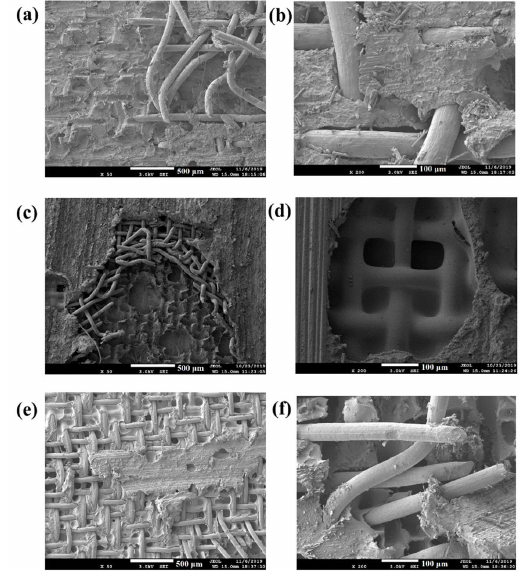
Figure 13. SEM of lap shear failure surfaces with similar LSS obtained with different types of heating elements: ( a ) type A heating element, LSS=37.3 MPa, × 50, ( b ) type A heating element, LSS=37.3 MPa, × 200, ( c ) type B heating element, LSS=35.6 MPa, × 50, ( d ) type B heating element, LSS=35.6 MPa, × 200, ( e ) type C heating element, LSS=34.8 MPa, × 50, ( f ) type C heating element, LSS=34.8 MPa, × 200.